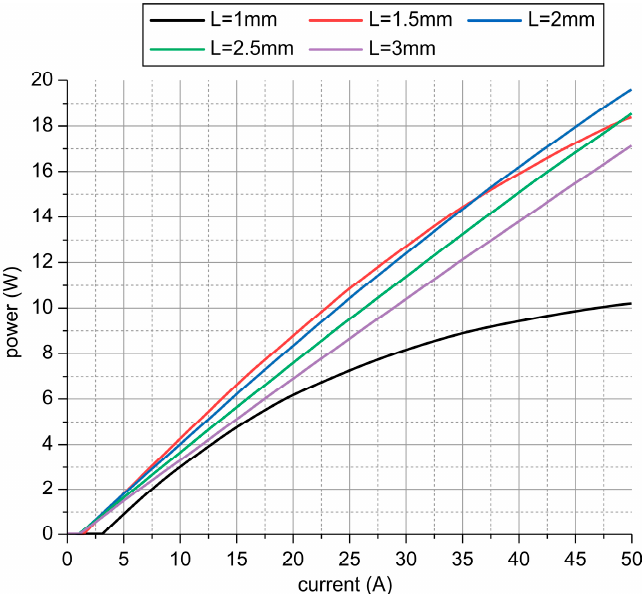
Figure 3. PI features simulated at different cavity lengths L (the reflectance values of the two optical facets is 0.3).